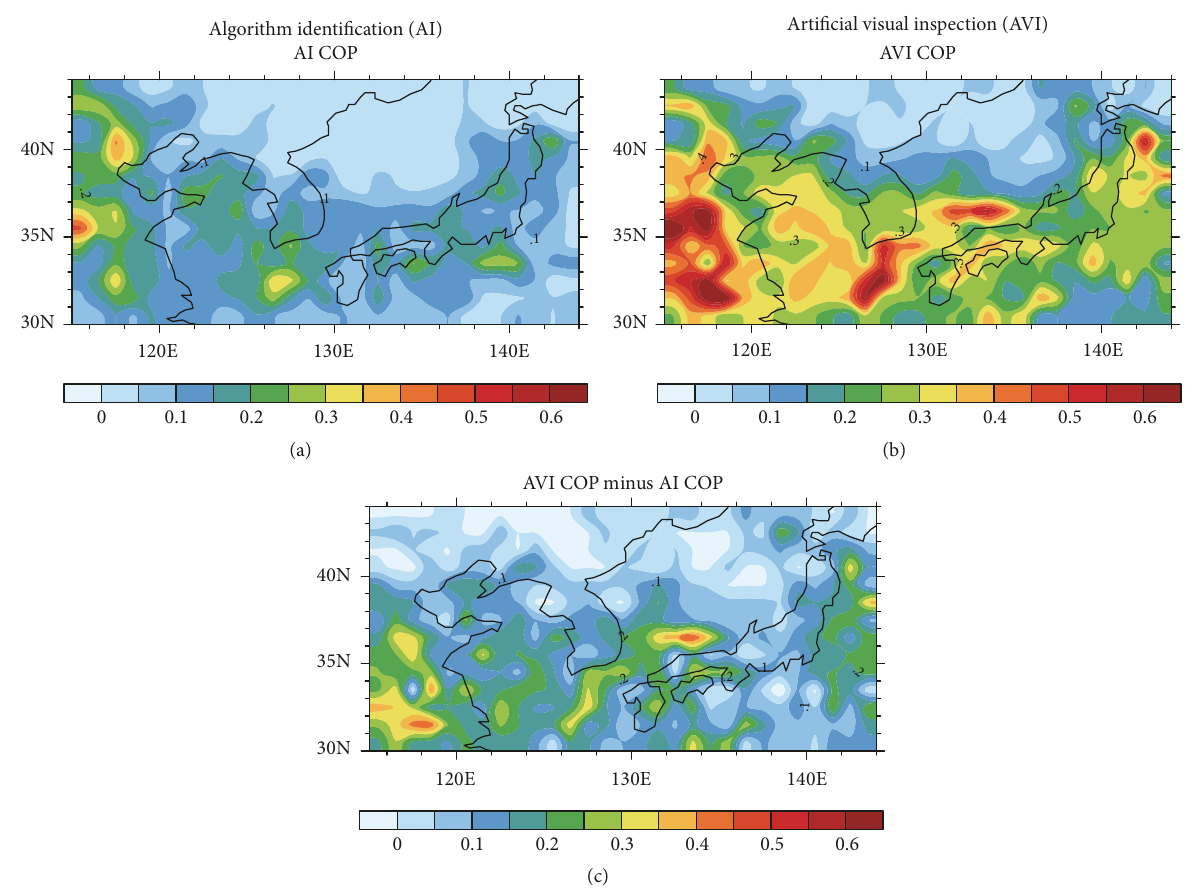
Figure 6: COP fraction counted from Himawari-8 imagery by using AI (a) and AVI (b), and (c) presents the difference between (a) and (b) during spring (Mar, Apr, and May) 2016.